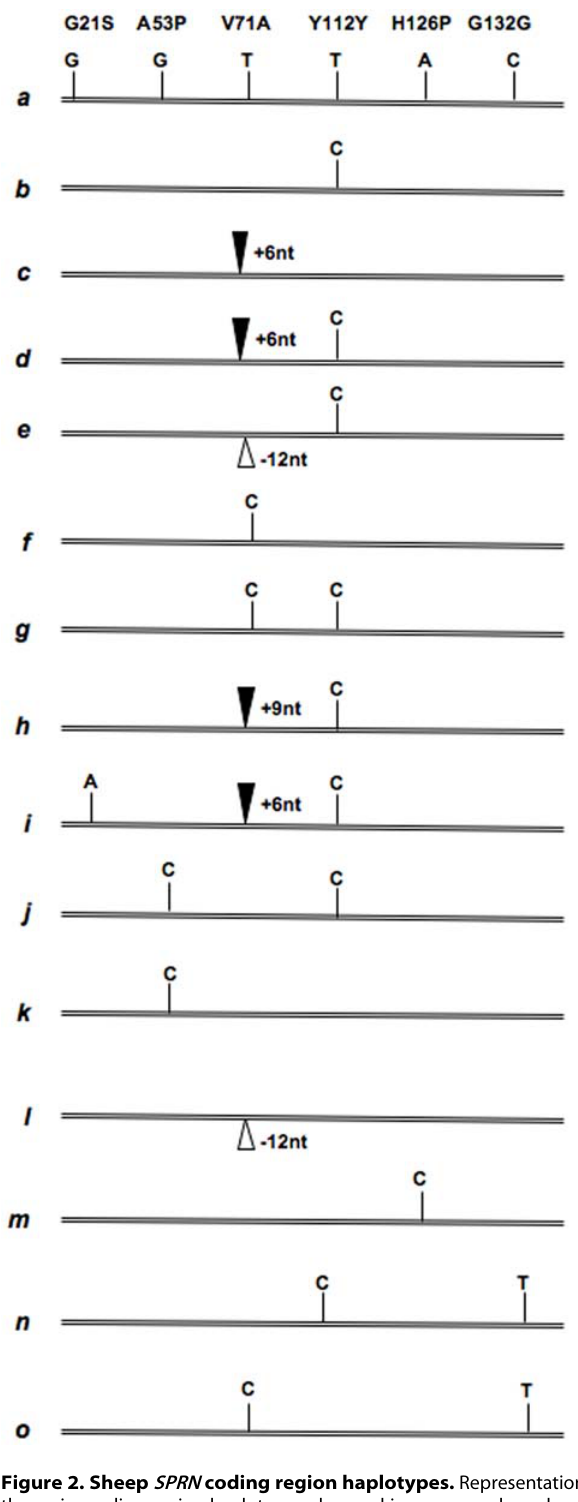
Figure 2. Sheep SPRN coding region haplotypes. Representation of the major coding region haplotypes observed in common sheep breeds. a and b , putative wild type ancestral haplotype and silent Y112Y polymorphism with a C residue in this codon, respectively; c, d , 6 bases insertion variants (solid fill triangle) of a and b , respectively: e , ‘‘ 2 12’’ nucleotide deletion haplotype (open triangle); f haplotype encoding alanine at codon 71 and g same with silent Y112Y polymorphism with a C residue in this codon. Haplotypes h to o comprises less common variants represented by 3 or fewer animals.